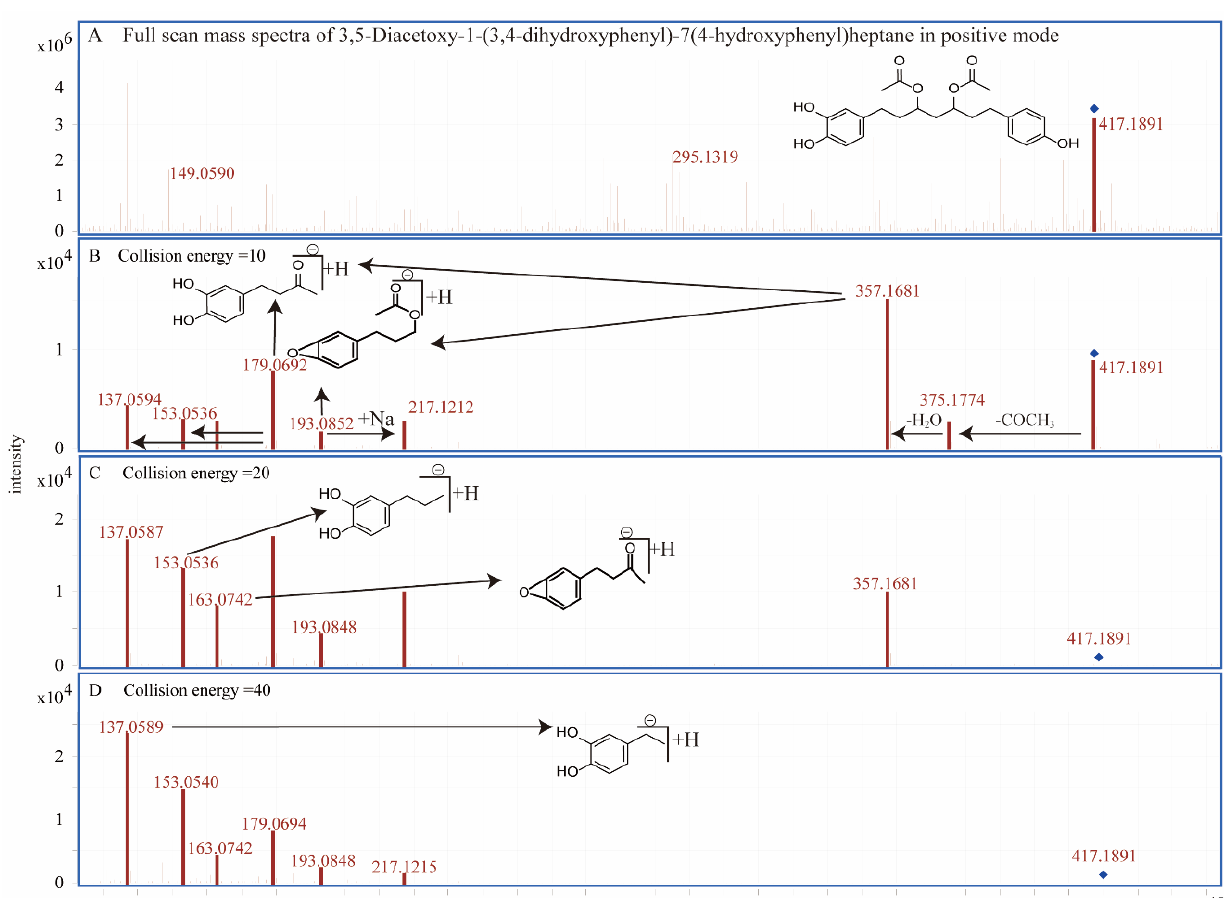
Figure 6. The mass spectra and the fragmentation pathway of compound 21, which was identified as 3,5-diacetoxy-1-(3,4-dihydroxyphenyl)-7(4-hydroxyphenyl) heptane. The mass spectra of com-